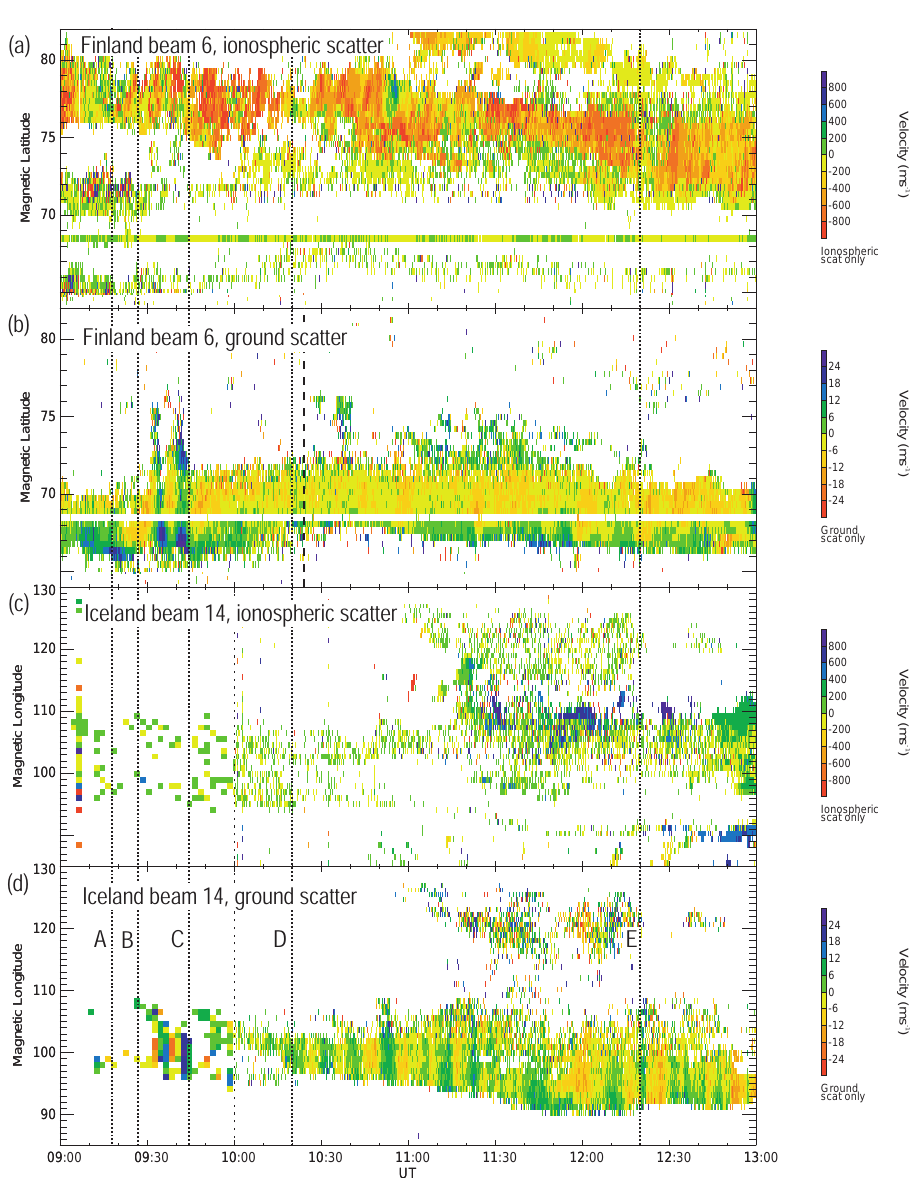
Fig. 3. Range-time-velocity plot for Finland beam 6 ionospheric scatter (top panel, (a) and ground scatter (b) , and Iceland East beam 14 ionospheric scatter (c) and ground scatter (d) , over 09:00–13:00UT on 23 February 1996. Vertical dotted lines indicate approximate arrival times at the ionosphere of events labelled “A” to “E” in Fig. 2. Finland ground scatter in (b) before 10:24UT, indicated by the vertical dashed line, is from behind the